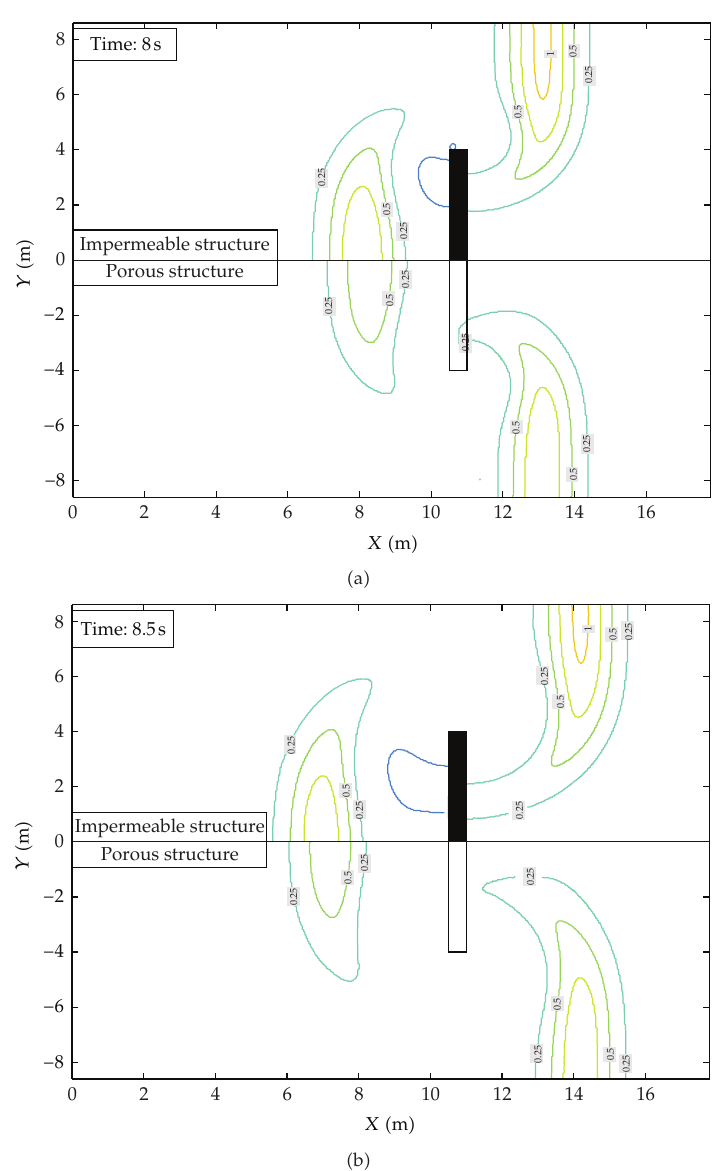
Figure 6: Free surface elevation isolines for the impermeable and porous structure under the action of the solitary wave case of height H (cid:7) 9cm and water depth h (cid:7) 40cm, part